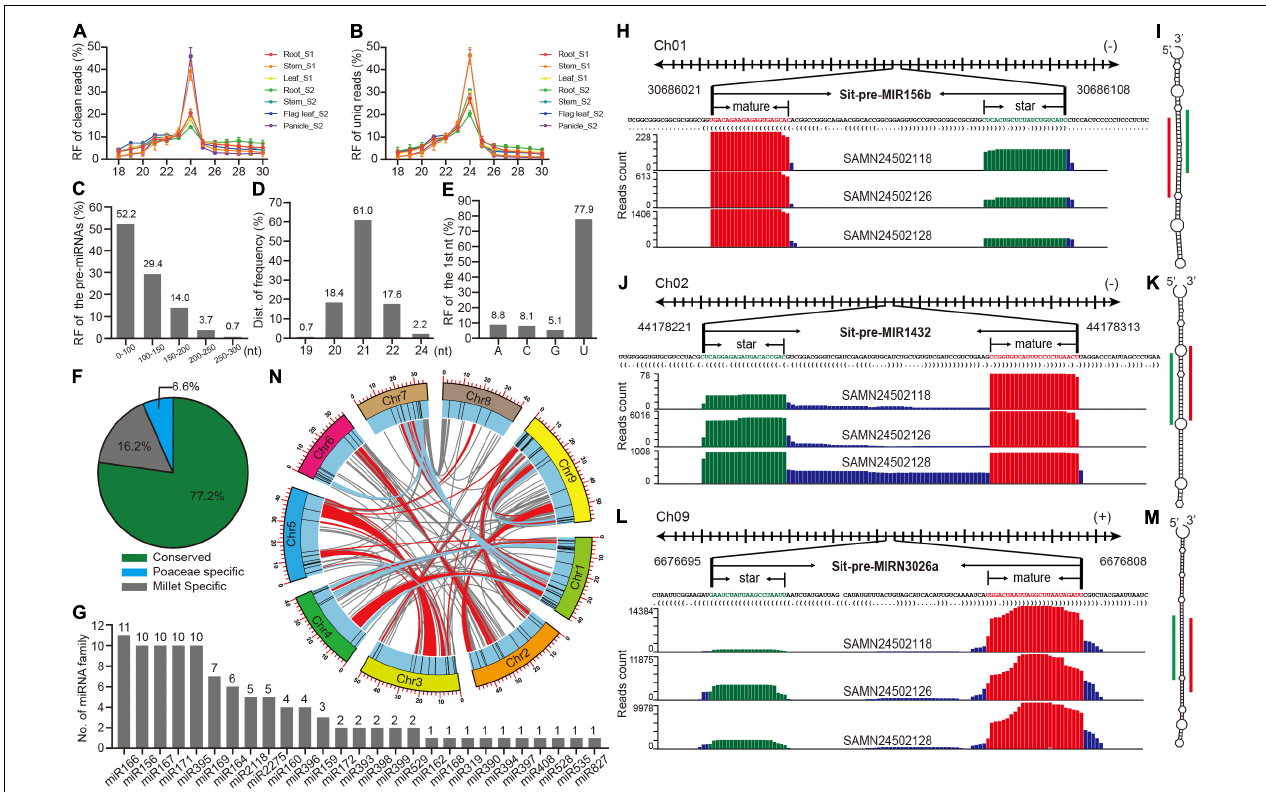
FIGURE 1 | Preliminary analysis of high confidence identified and annotated miRNAs in foxtail millet. (A,B) Length distribution of clean and unique reads from sRNA libraries in multiple tissues. (C) Length distribution of pre-miRNAs. (D) Length distribution of mature miRNAs. (E) The proportion of the first nucleotide from mature miRNAs. (F) The proportion of three types of miRNAs. (G) Member distributions of conserved miRNA families. (H) The detailed information and reads mapping to the genome loci of pri-miR156b and pre-miR156b sequences, where mature and star Sit-miR156b are colored with red and green, respectively. (I) The secondary structure of pre-miR156b by RNAfold. Mature and star Sti-miR156b are labeled with red and green lines. (J–M) The information of Sit-miR1432 and Sit-miRN3026N represented examples of Poaceae-specific and foxtail millet-specific miRNAs, respectively. (N) Anchored information of the foxtail millet miRNAs in synteny blocks, while red and blue lines manifest single miRNA and paired miRNAs located in the synteny blocks, respectively.